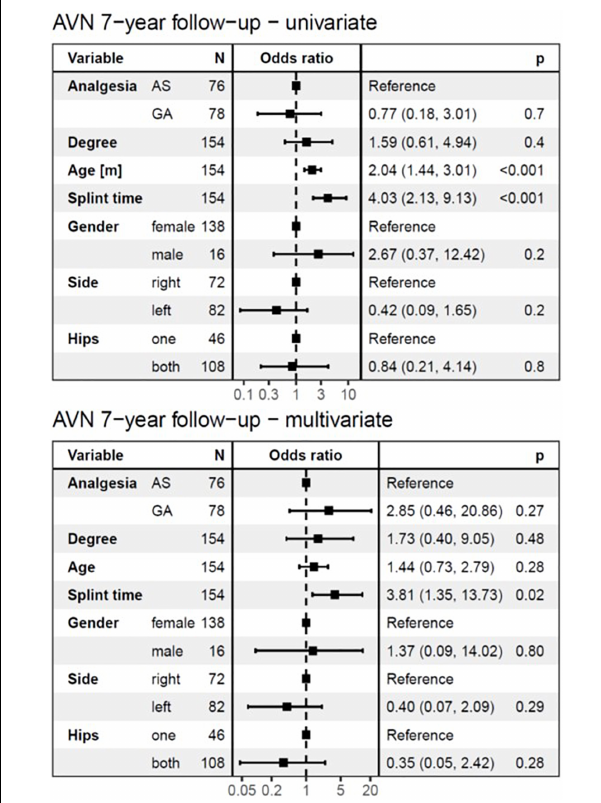
FIGURE 5 | The logistic regression model at 7-years follow-up. The univariate analysis showed no significant difference in the development of AVN between AS and GA groups and identified age at diagnosis and splint time as substantial risk factors. In the multivariate analysis, only splint duration showed a significant influence on the development of AVN at a 7-years follow-up. For every month of longer splint duration for the treatment of DDH, the odds of AVN at 7-years follow-up increased by a factor of 4.03 (95% CI : 2.13–9.13, p < 0.001) in univariate analysis, and 3.81 (95%CI: 1.35–13.73,